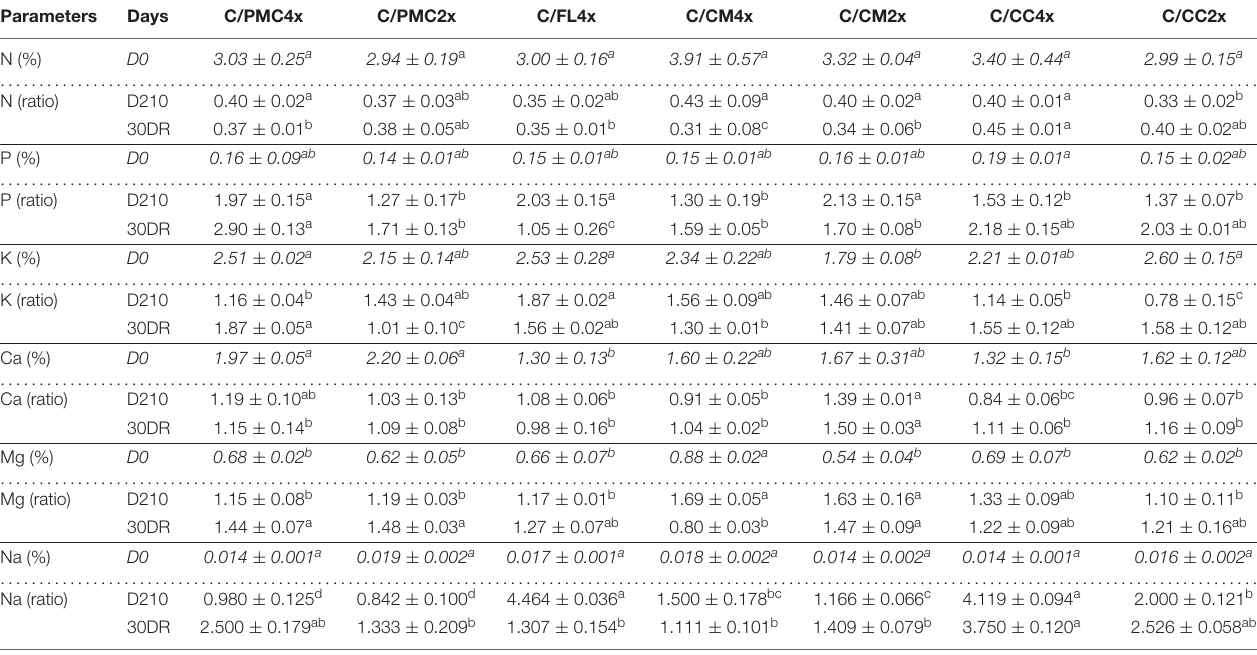
Data shown at D210 and 30DR are means (n = 3 ± standard error) expressed as ratios with respect to the values obtained on control which have not been subjected to stress. For further informations, means values of control data (D0) (n = 3 ± standard error) were also included and indicated by italics characters. Data were